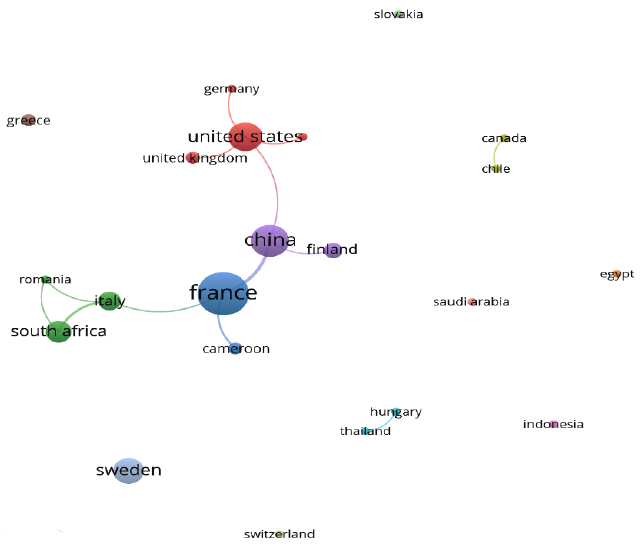
Figure 5. Collaboration network of countries according to papers analyzed in network visualization (VOSviewer).